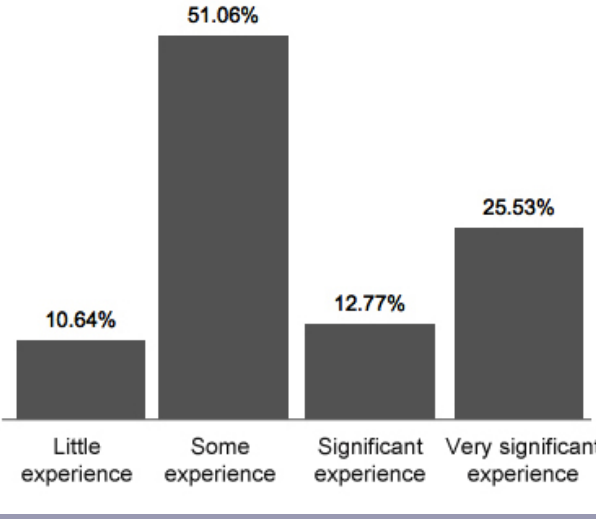
Fig. 2. Diversity of respondents in terms of levels of experience with adaptive